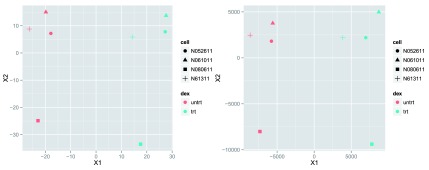
MDS plots.Shown are the plots based on the rlog-transformed values (left) and the
Poisson Distance (right).